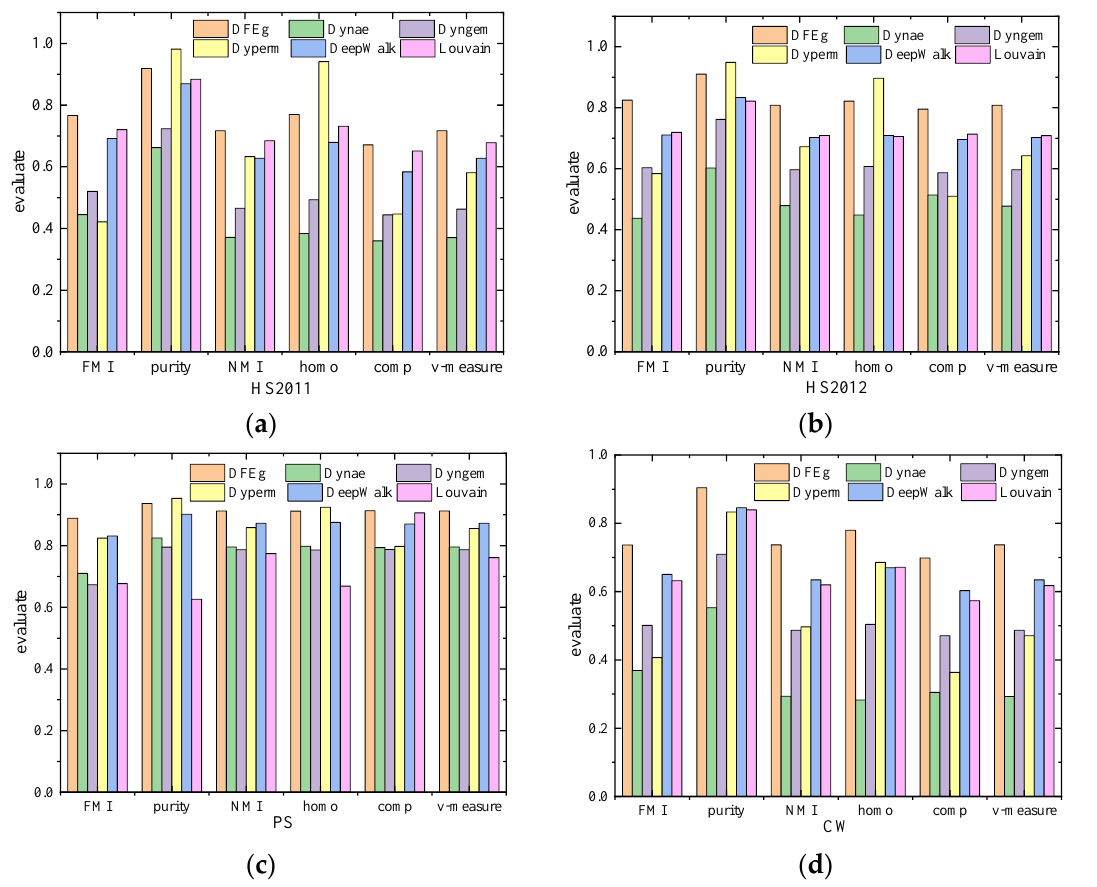
Figure 5. Avg evaluation results of each algorithm in the real-world dataset. ( a ) Avg results of algorithms with HS2011. ( b ) Avg results of algorithms with HS2012. ( c ) Avg results of algorithms with PS. ( d ) Avg results of algorithms with CW.